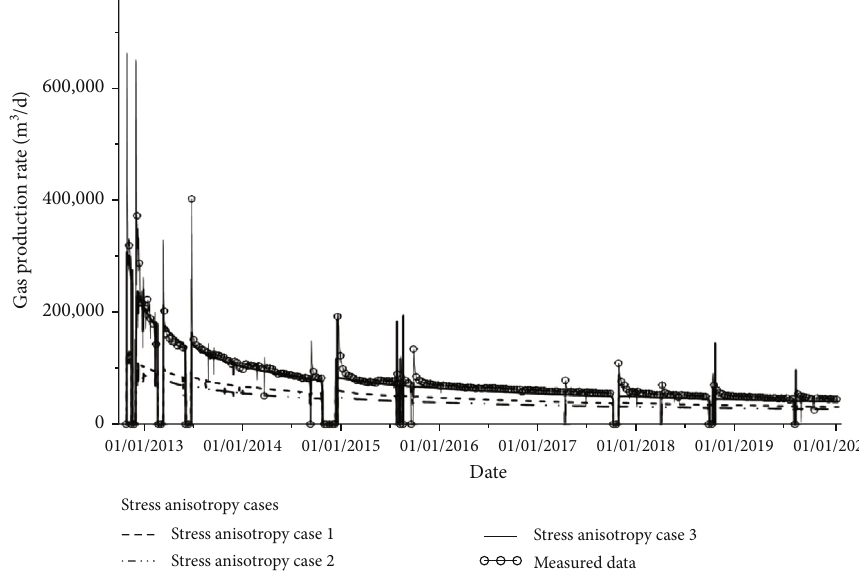
Figure 11: Reservoir simulation results of di ff erent stress